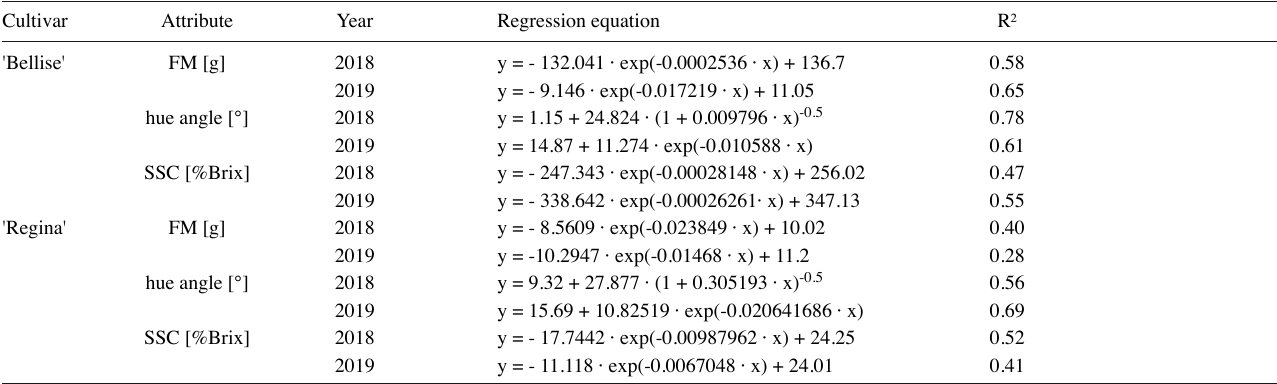
Tab. 3: Equations relating fruit quality attributes, y, and leaf area to fruit ratio (LA:F), x, and corresponding coefficient of determination, R ² , of 'Bellise' and 'Regina' sweet cherry fruits in two years.